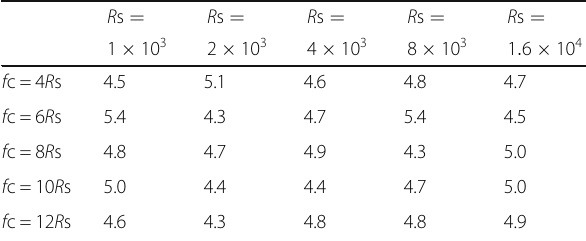
Table 1 Average convergence times under different signal